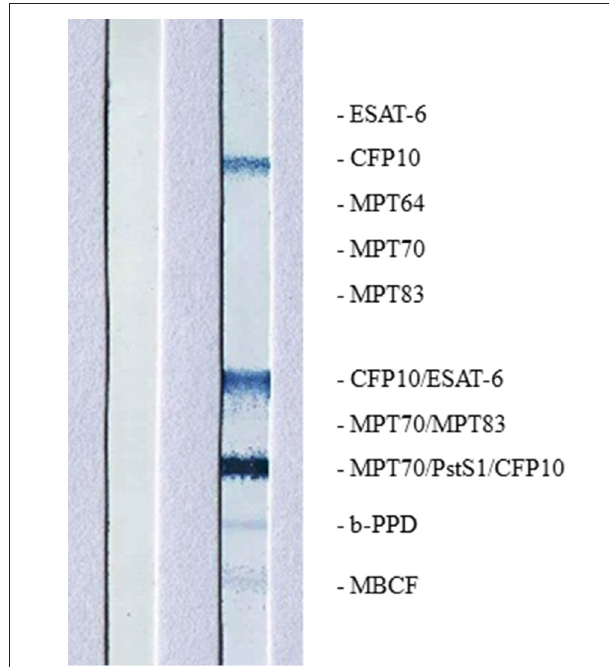
FIGURE 5 | Image of MAPIA results are shown for African elephant diagnosed with Mtb disease (right strip) and a negative control African elephant (left strip); names and positions of immobilized antigens are shown on the right margin; visible bands on the strip indicate the presence of IgG antibody to corresponding antigens.